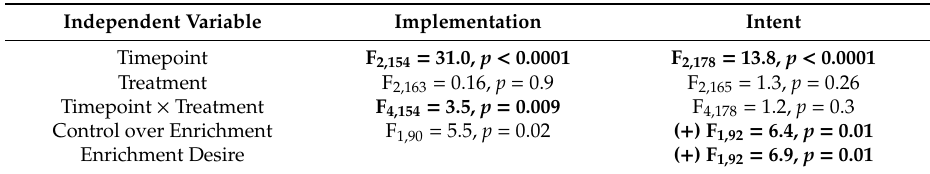
Table 2. Implementation and intent to provide rat tickling. The associations from general linear mixed models of self-reported data from laboratory animal personnel. Participants were asked about their current implementation and intent to provide rat tickling to their laboratory rats.